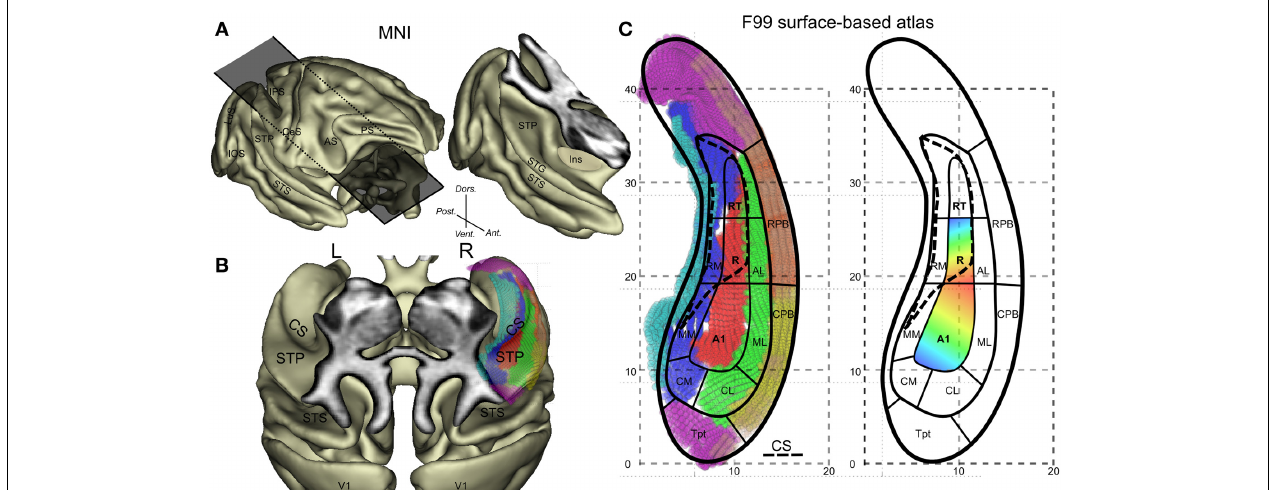
FIGURE 1 | General anatomical description of the monkey auditory cortex and its subdivisions. (A) Lateral view of the 3D cortical surface reconstructed from the MNI-space template and illustration of an oblique cut above the temporal lobe. (B) Top oblique view on the surface of the superior temporal plane with identification of the circular sulcus (CS). The overlay of the F99 surface based atlas and its auditory subfields onto the right lateral sulcus are also shown. (C) Detailed subdivisions of the auditory subfields with vertex in different colors and schematic outlines and typical tonotopic